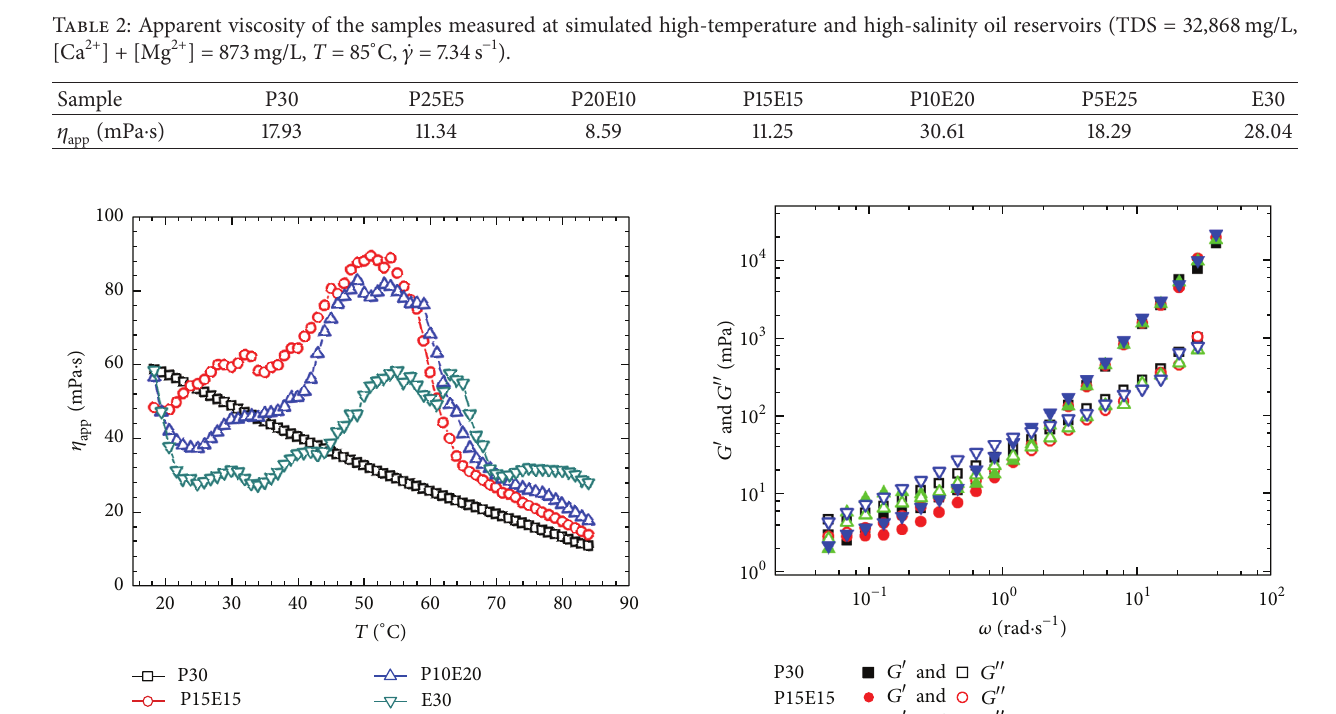
Table 2: Apparent viscosity of the samples measured at simulated high-temperature and high-salinity oil reservoirs (TDS = 32,868 mg/L,